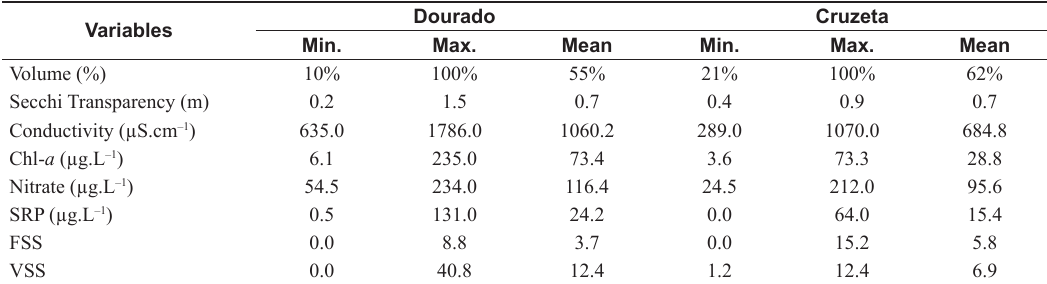
Figure 2. Precipitation in Dourado (A) and Cruzeta (B) reservoirs. The study began in the end of the rainy season when precipitation values were higher than or close to the historical average values (May-July 2011). Table 1. Minimum, maximum and mean values of variables on each reservoir.